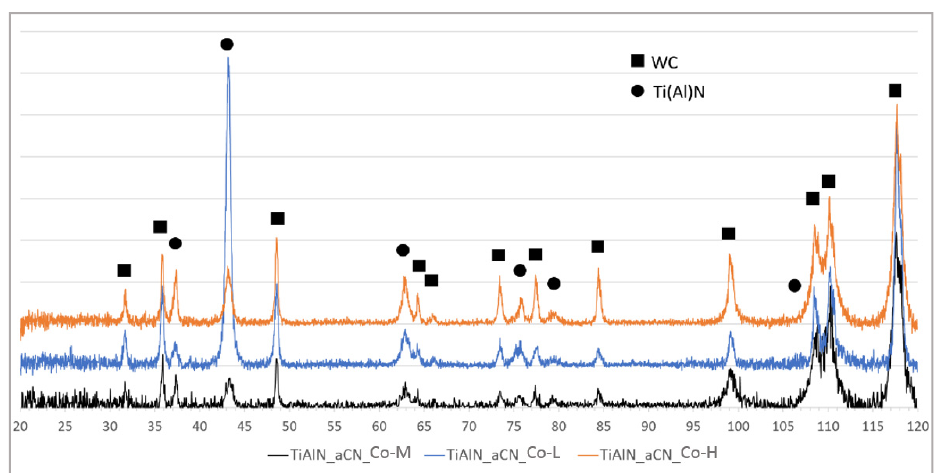
Figure 2. XRD analysis graph of 5 µm thick TiN/AlTiN coating deposited on three different ce- mented carbide substrates: Co-L, Co-M and Co-H.